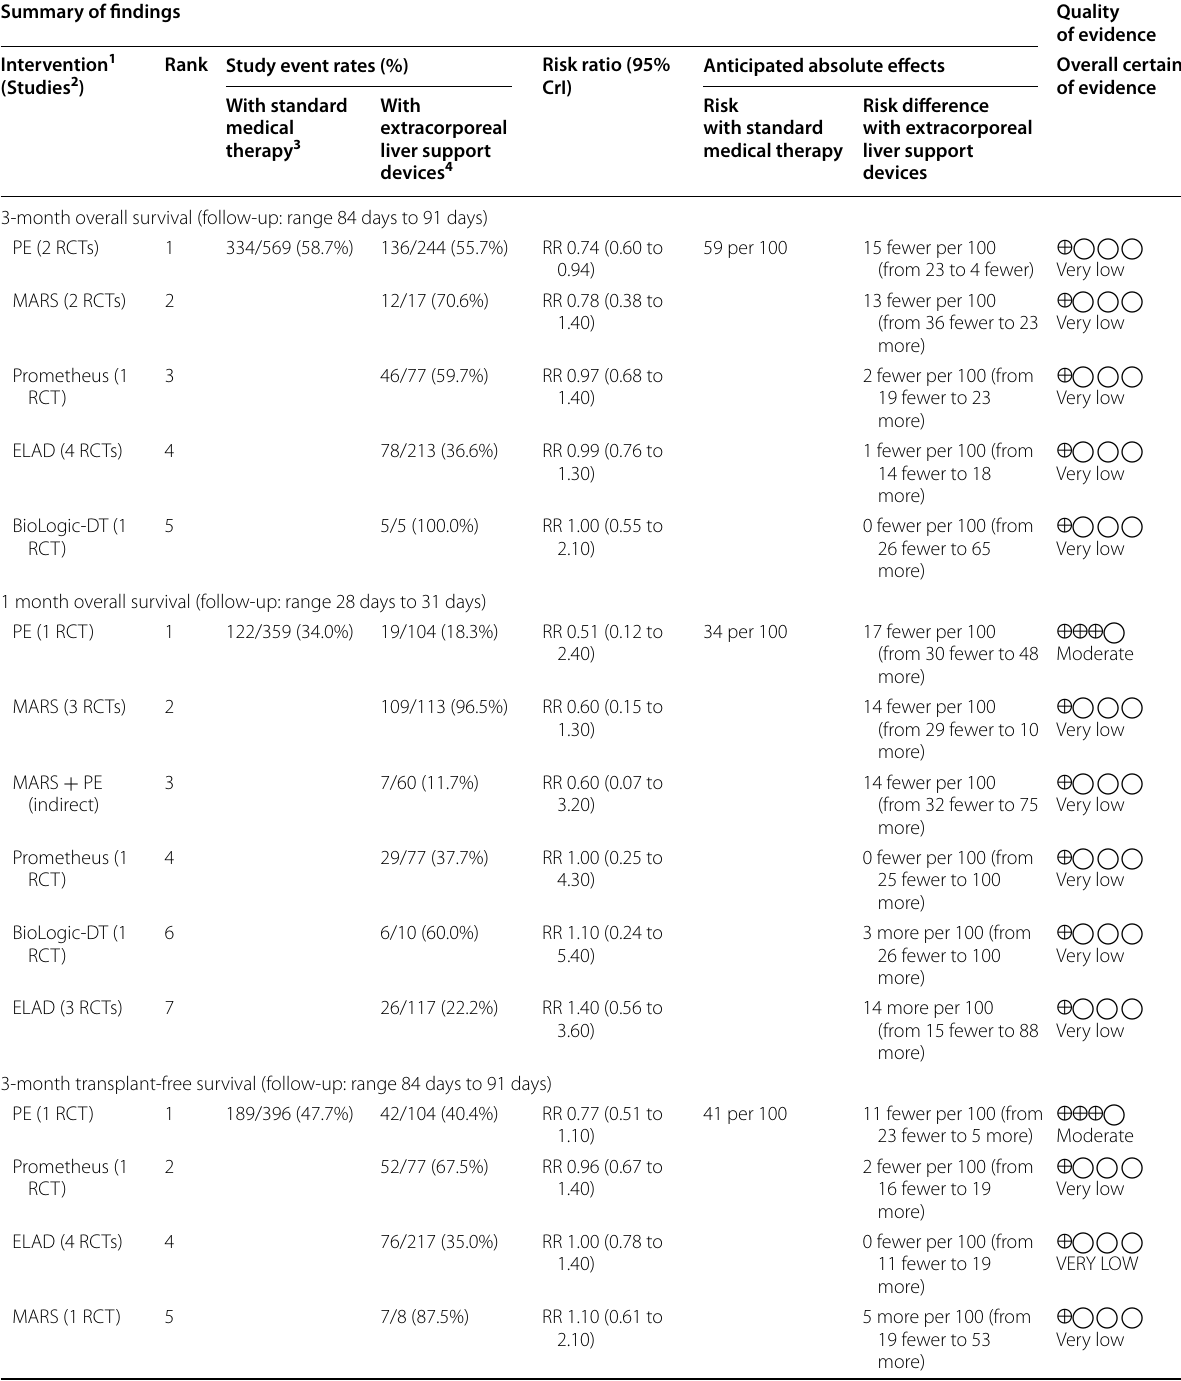
Table 2 Summary of findings Summary of